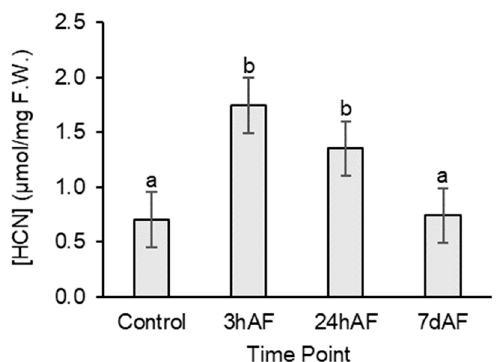
Figure 3. HCN concentration ( µ mol/mg fresh weight) in leaves of AcLi plants (N = 10) at four time points during the freezing experiment: Control (no freezing), 3 h after freezing (3hAF), 24 h after freezing (24hAF), and 7d after freezing (7dAF). Bars represent means ± 1 SE. Significant differences ( p < 0.05) among time point means are indicated by lowercase letters after pairwise contrasts.